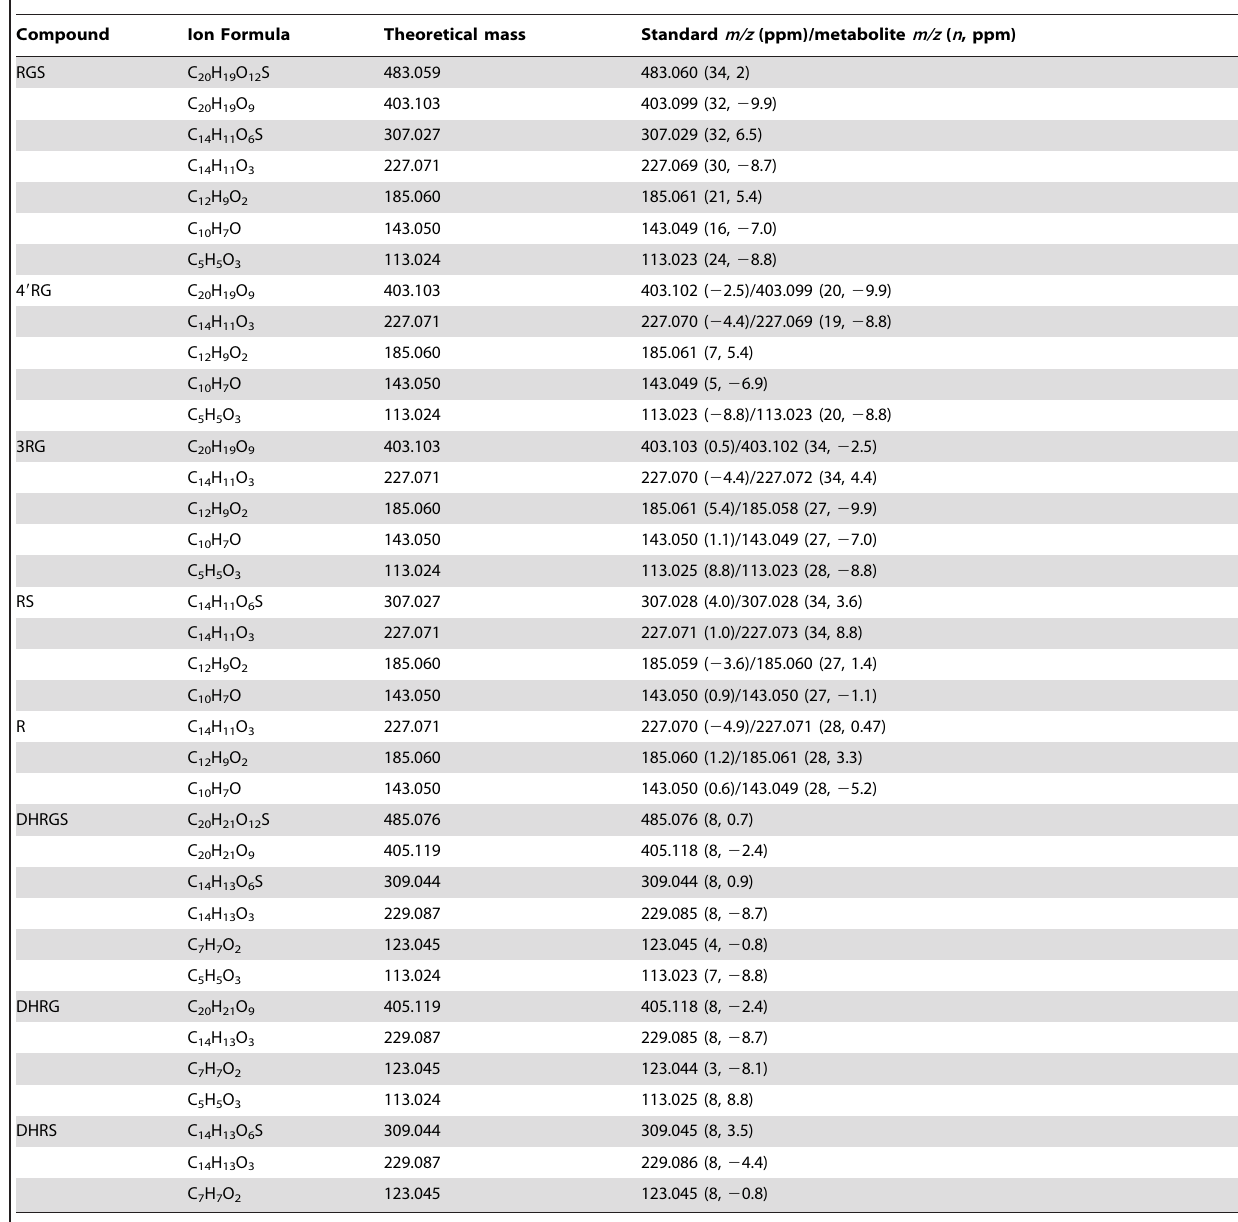
Table 1. m/z average and accuracy (ppm) for precursor and daughter ions of resveratrol and their metabolites.